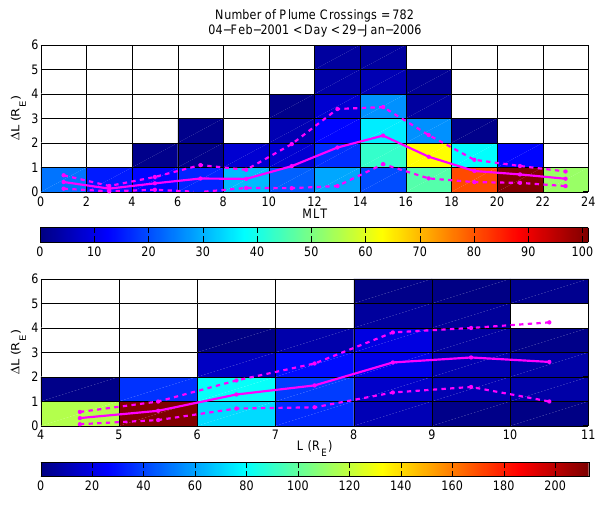
Fig. 13. Distribution of plasmaspheric plumes observed by WHIS- PER onboard Cluster during the five years of data analysed. The density variation 1N is shown as a function of MLT in the top panel, and as a function of L in the bottom panel. The color code gives the number of events in each bin. The solid magenta curves give the mean 1N value inside each MLT range in the top panel, and inside each L range in the bottom panel, and the two dashed magenta curves the standard deviations of those